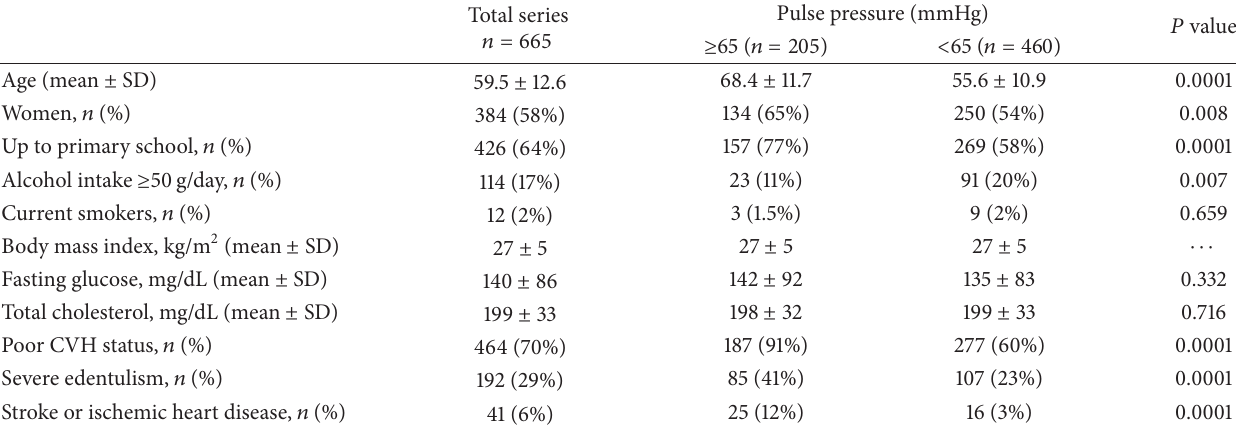
Table 4: Characteristics of Atahualpa residents aged ≥ 40 years according to pulse pressure